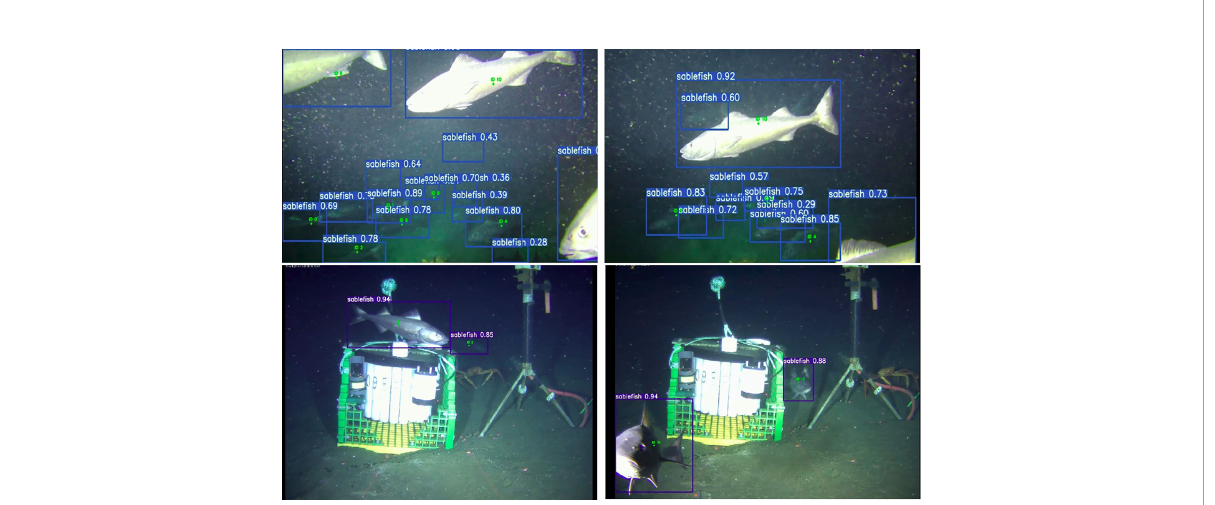
FIGURE 3 Examples of the outcome of detection, classi fi cation, and tracking of sable fi sh individuals. Bounding boxes and the corresponding con fi dence levels are the result of the YOLO detection and classi fi cation algorithm, where the classi fi cation con fi dence ranges from 0 to 1. Green numbered points (barely visible in the images) are the result of the tracking algorithm, approximating the count of unique individuals appearing on video. The images at the top show two video frames at 5 and 7 seconds elapsed from a video clip recorded in Barkley Axis on October 17th 2019 at 11:00 am UTC. The images at the bottom show two video frames at 31 seconds and 2 minutes elapsed from a video clip recorded in Barkley Node on October 21st 2019 at 8:04 am